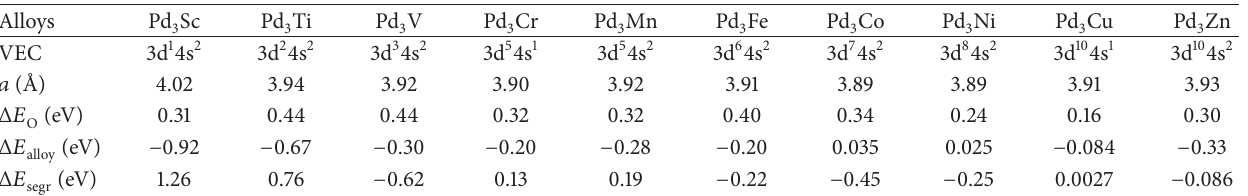
Table 1: The DFT calculated lattice constants, formation energies, Δ𝐸 M (M is 3d transition metals) alloys and adsorption energies difference of O atom between Pd-segregated Pd Pd 3 Δ𝐸 (eV). O